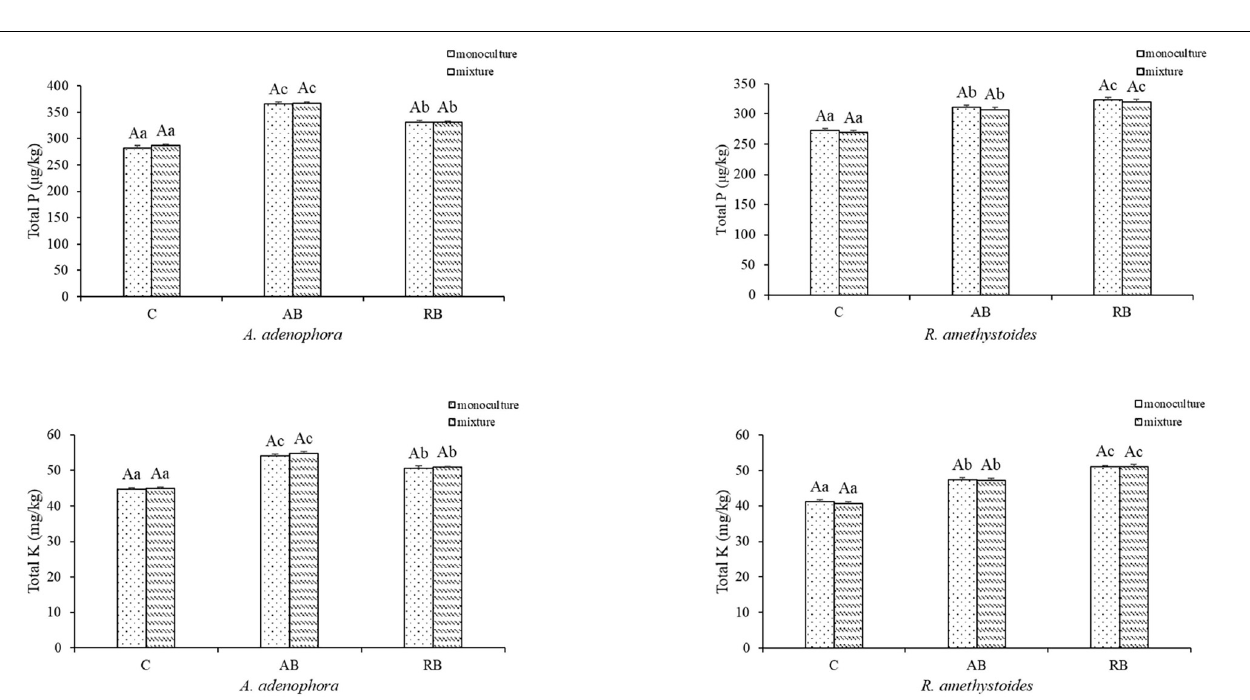
FIGURE 5 | Effect of Bacillus on plant total phosphorus and potassium concentrations of invasive plant A. adenophora and native plant R. amethystoides when grown in monoculture or in mixture. Different lowercase letters indicate significant differences among the inoculation treatments at p < 0.05. Different capital letters indicate significant differences between the monoculture and mixture at p < 0.05. Error bars represent ± 1SE of the mean ( n = 5).